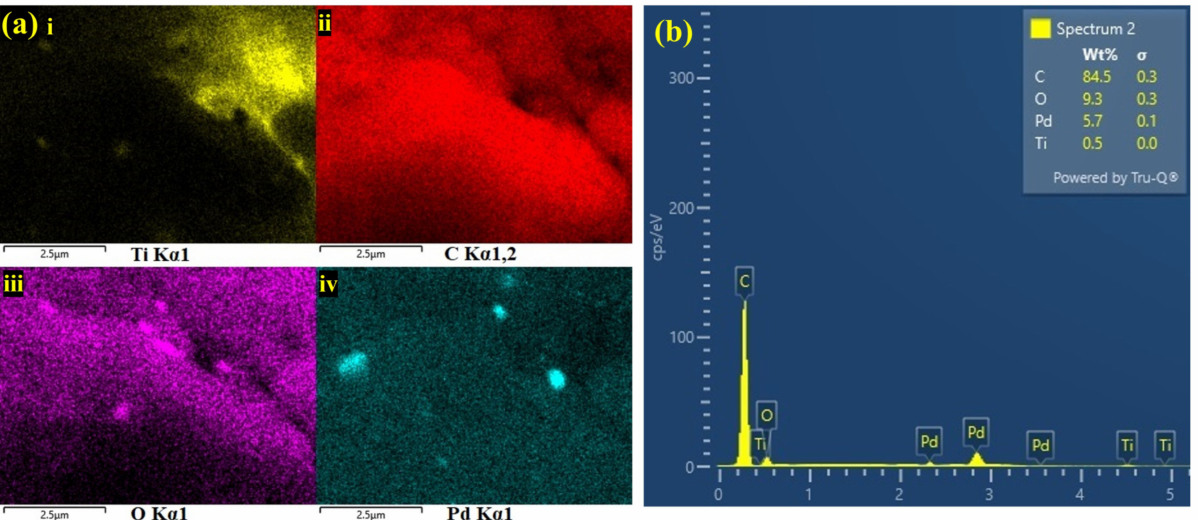
Figure 5. ( a ) Elemental mappings were performed on MXene/PHC composite: ( i ) titanium, ( ii ) carbon, ( iii ) oxygen and ( iv ) palladium. ( b ) EDS spectrum of MXene/PHC